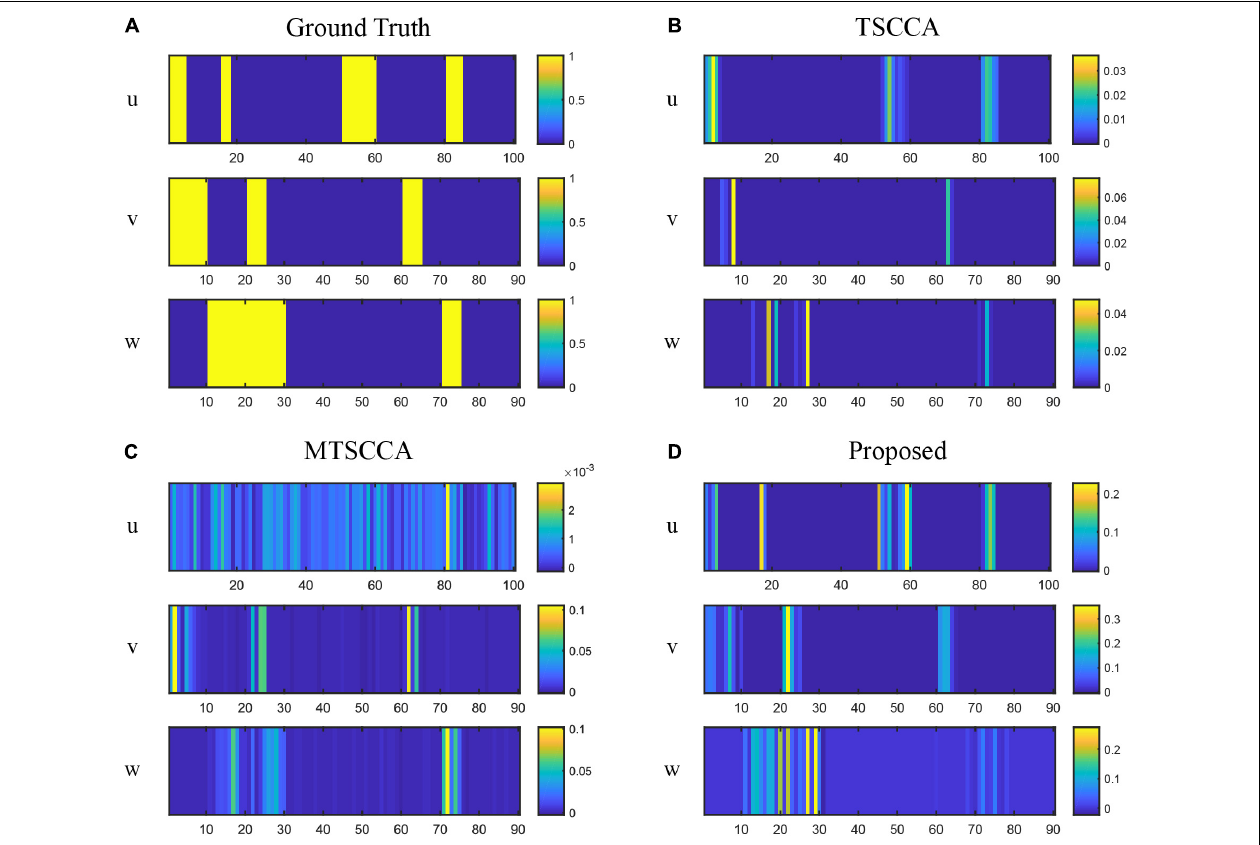
FIGURE 4 | Comparison of canonical weights on synthetic data with the high noise level. (A) The ground truth canonical weights. (B) The estimated canonical weights of TSCCA. (C) The estimated canonical weights of MTSCCA. (D) The estimated canonical weights of the proposed